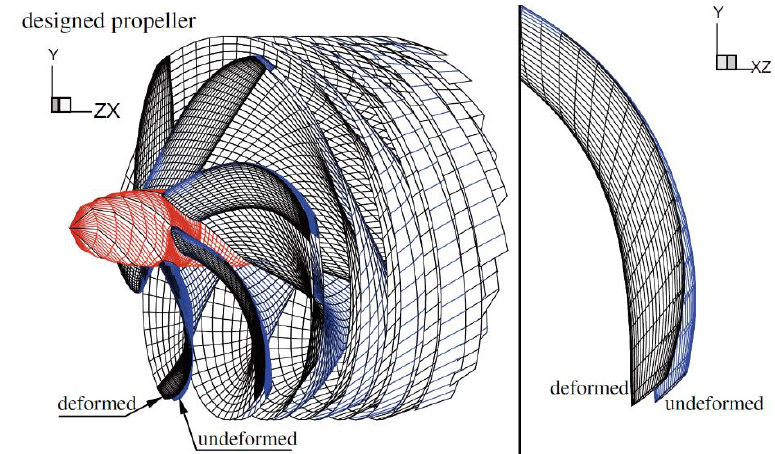
Figure 7. Undeformed and deformed geometry of a marine turbine with bend-twist coupled composite blades for improved efficiency [8].